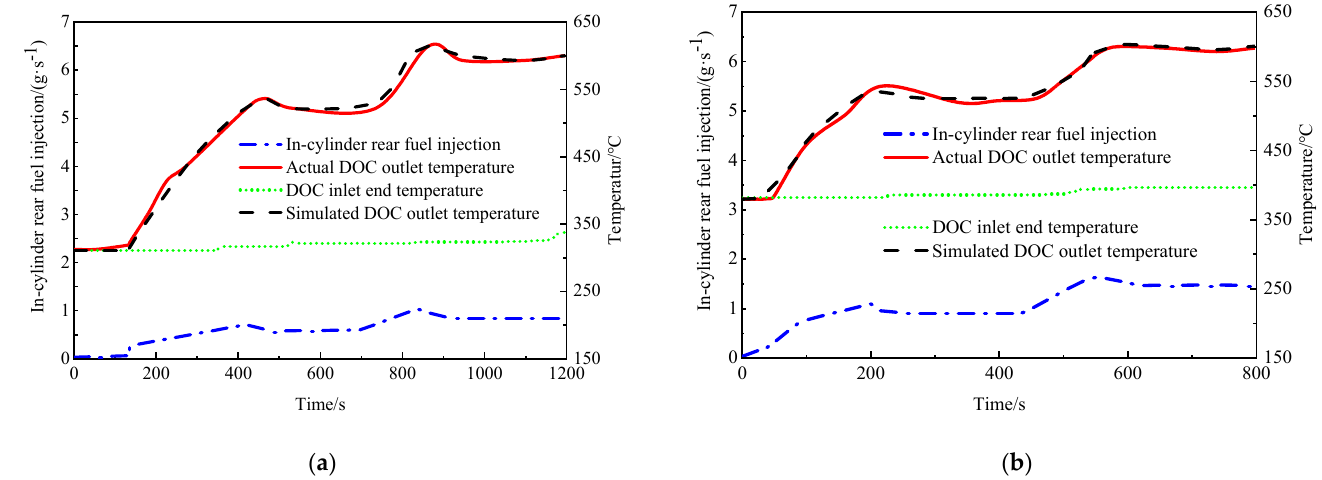
Figure 15. Comparison of the model simulation results with the testing results; ( a ) DOC airspeed is 5 × 10 4 h − 1 ; ( b ) DOC airspeed is 10 × 10 4 h − 1.